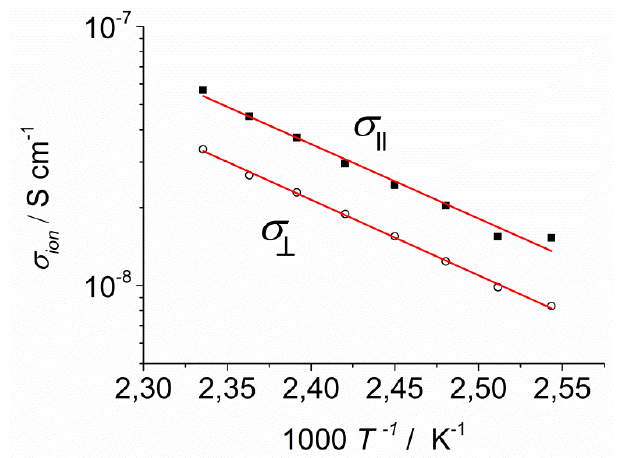
Figure 12. Arrhenius diagram of the ionic conductivity parallel 𝜎 ∥ ( ■ ) and perpendicular 𝜎 ⊥ ( ○ ) to the columns in the columnar phase of KI-2c . 391